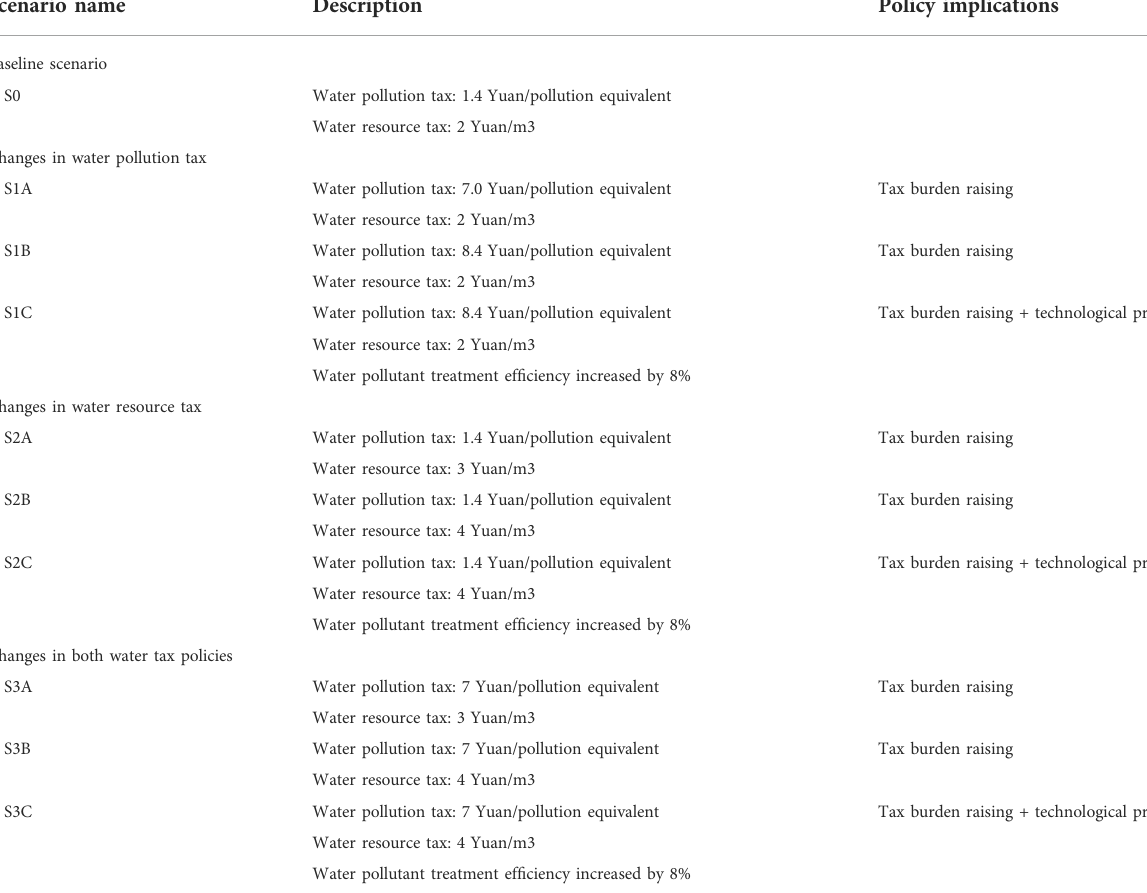
TABLE 2 Instructions of simulation scenarios.